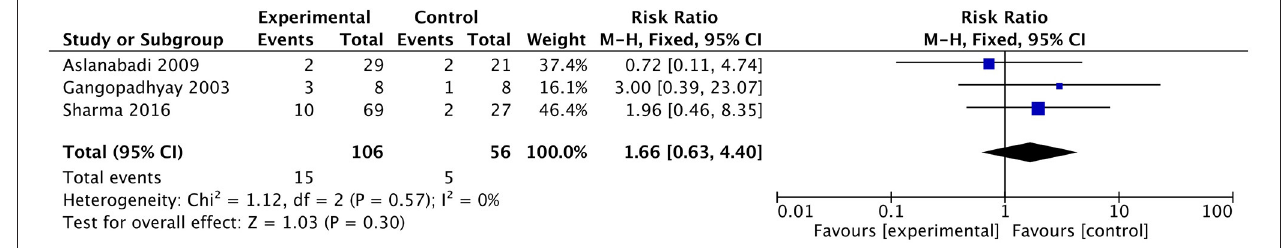
FIGURE 6 | Forest plot for anastomosis